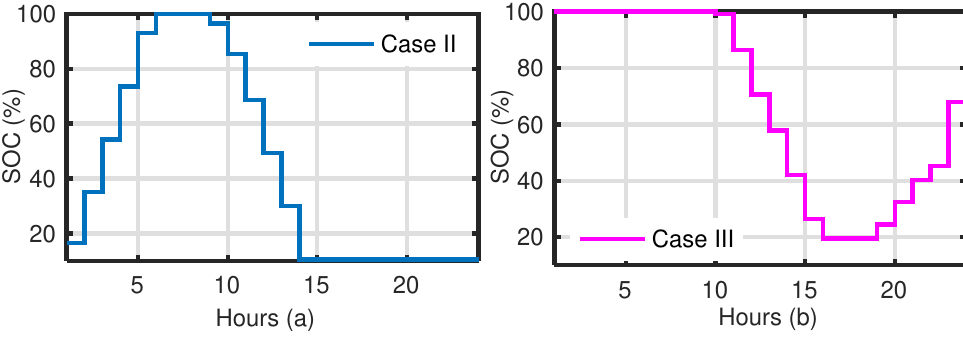
Figure 2. Hourly SOC (%) of the BESS in ( a ) Case II, and ( b ) Case